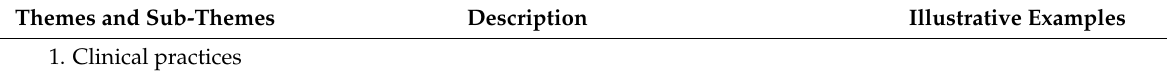
Table 2. Themes, Categories, Descriptions, and Illustrative Examples of Focus Group Discussion on Perceptions of Telehealth Services for Hearing Loss in the Public Healthcare